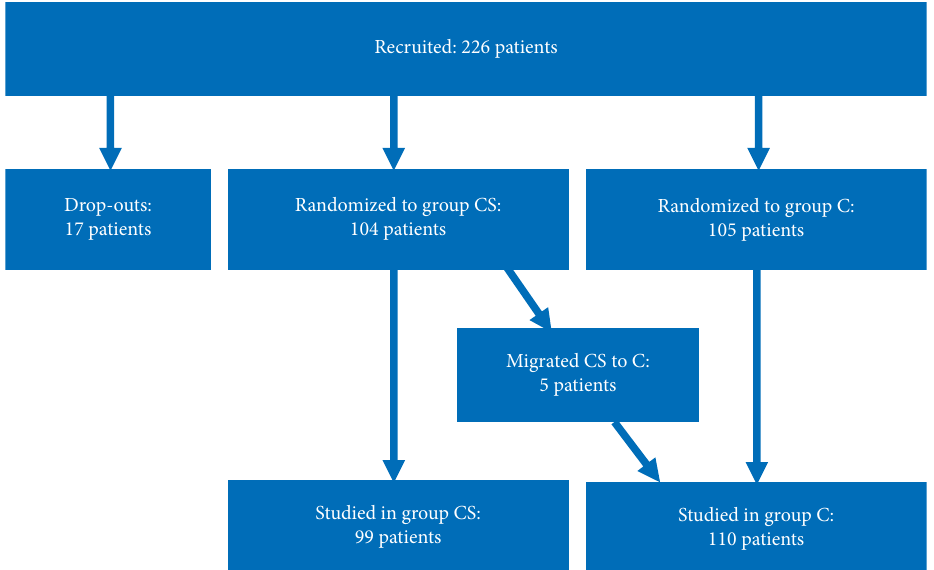
Scheme 1: Recruitment and randomization of patients in cell salvage (CS) and control (C) groups.